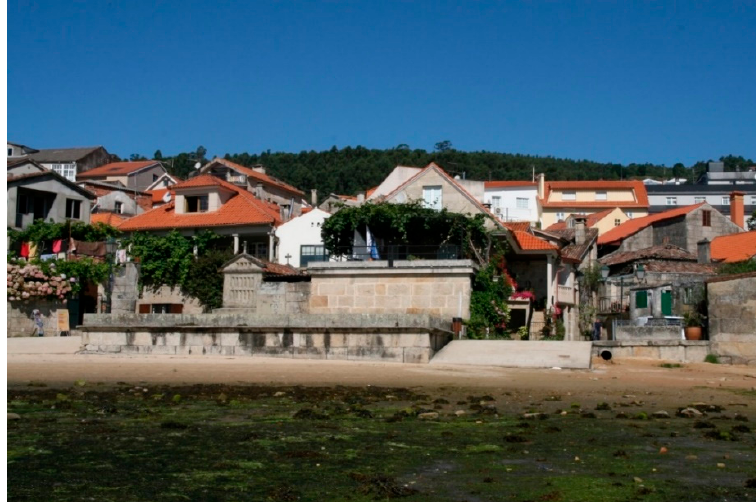
Figure 2. Photo of the Rualeira Square, showing the skyline of Combarro with the granaries and the coastal wall (Authorship: AFC).